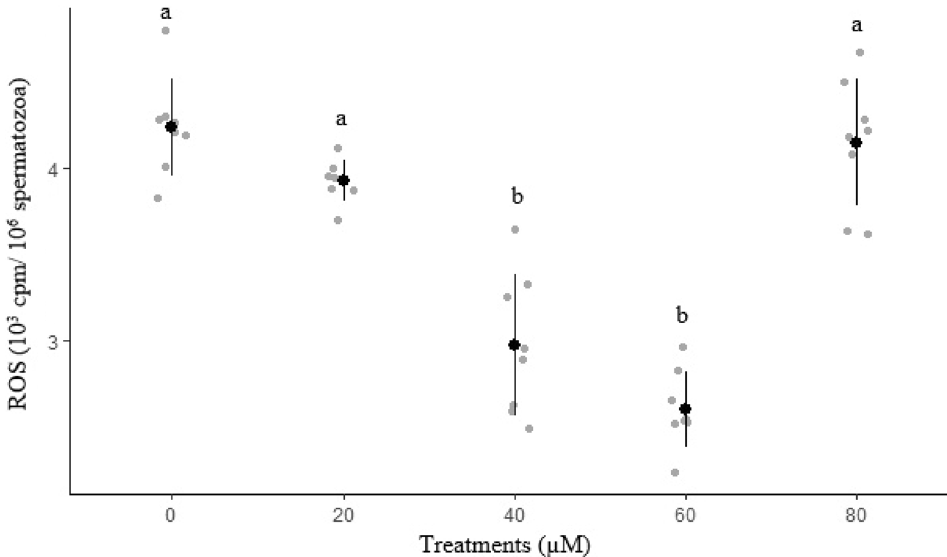
Figure 6. Effect of different levels of rosiglitazone on ROS of ram thawed semen.